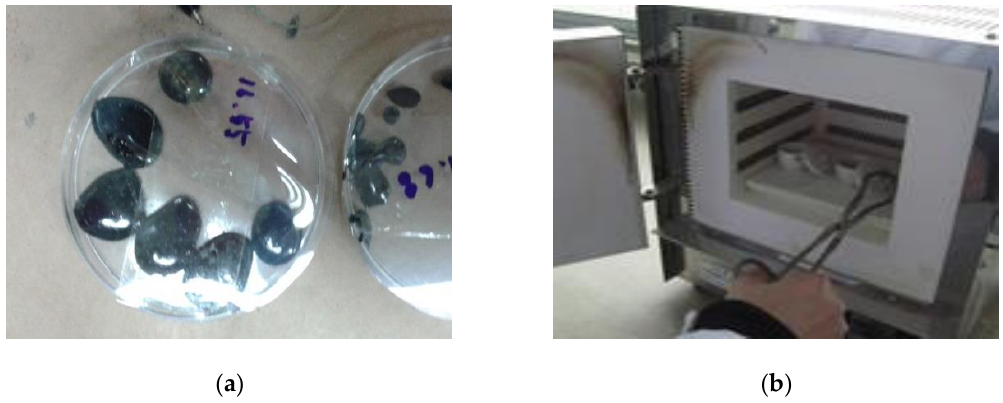
Figure 7. Filler content measurement; (a) leaked oil collection, (b) set in an electric furnace.